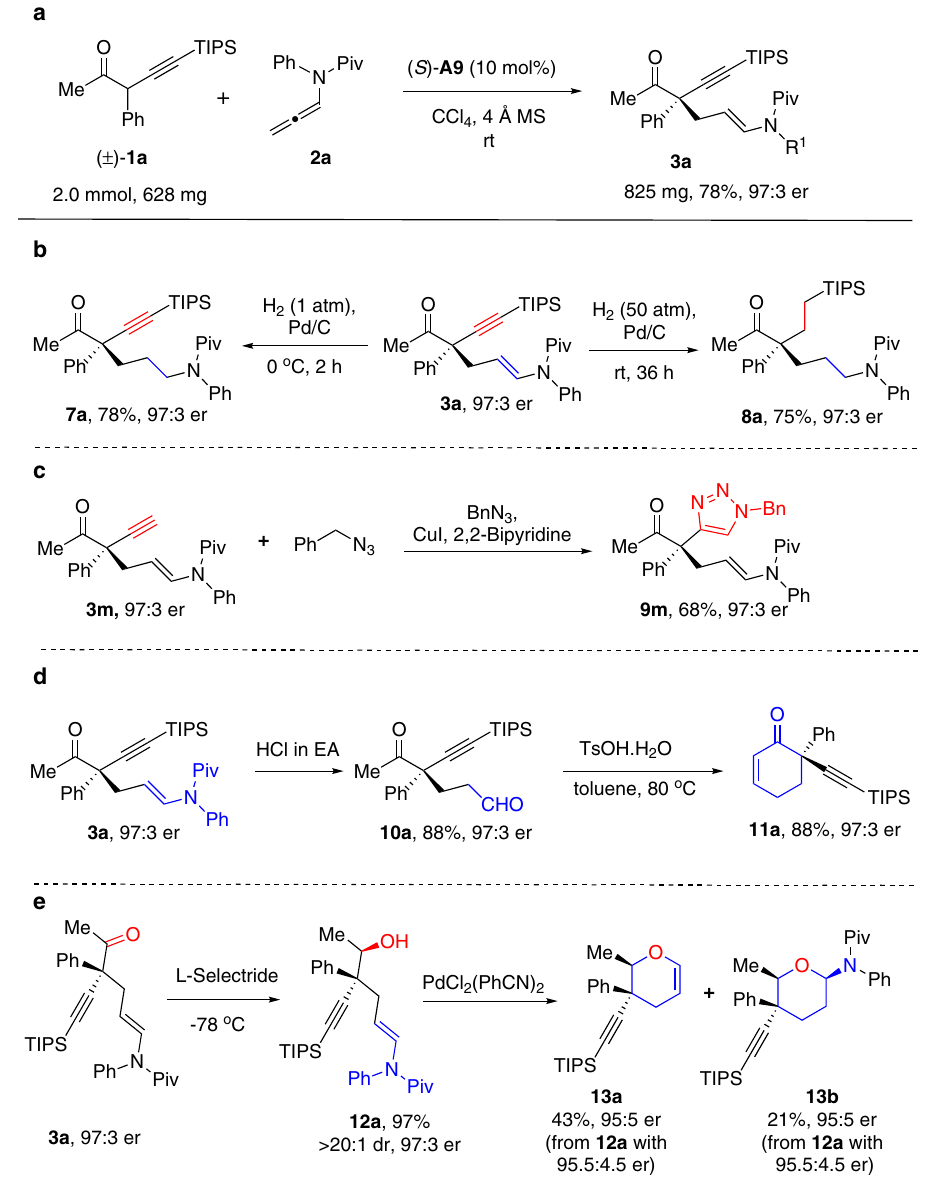
Fig. 8 Large-scale reaction and derivatizations of the chiral products. a Gram-scale reaction. b Hydrogenation of 3a. c Cycloaddition of 3a with organic azide. d Hydrolysis and aldol reaction of 3a . e Reduction and cyclization of 3a